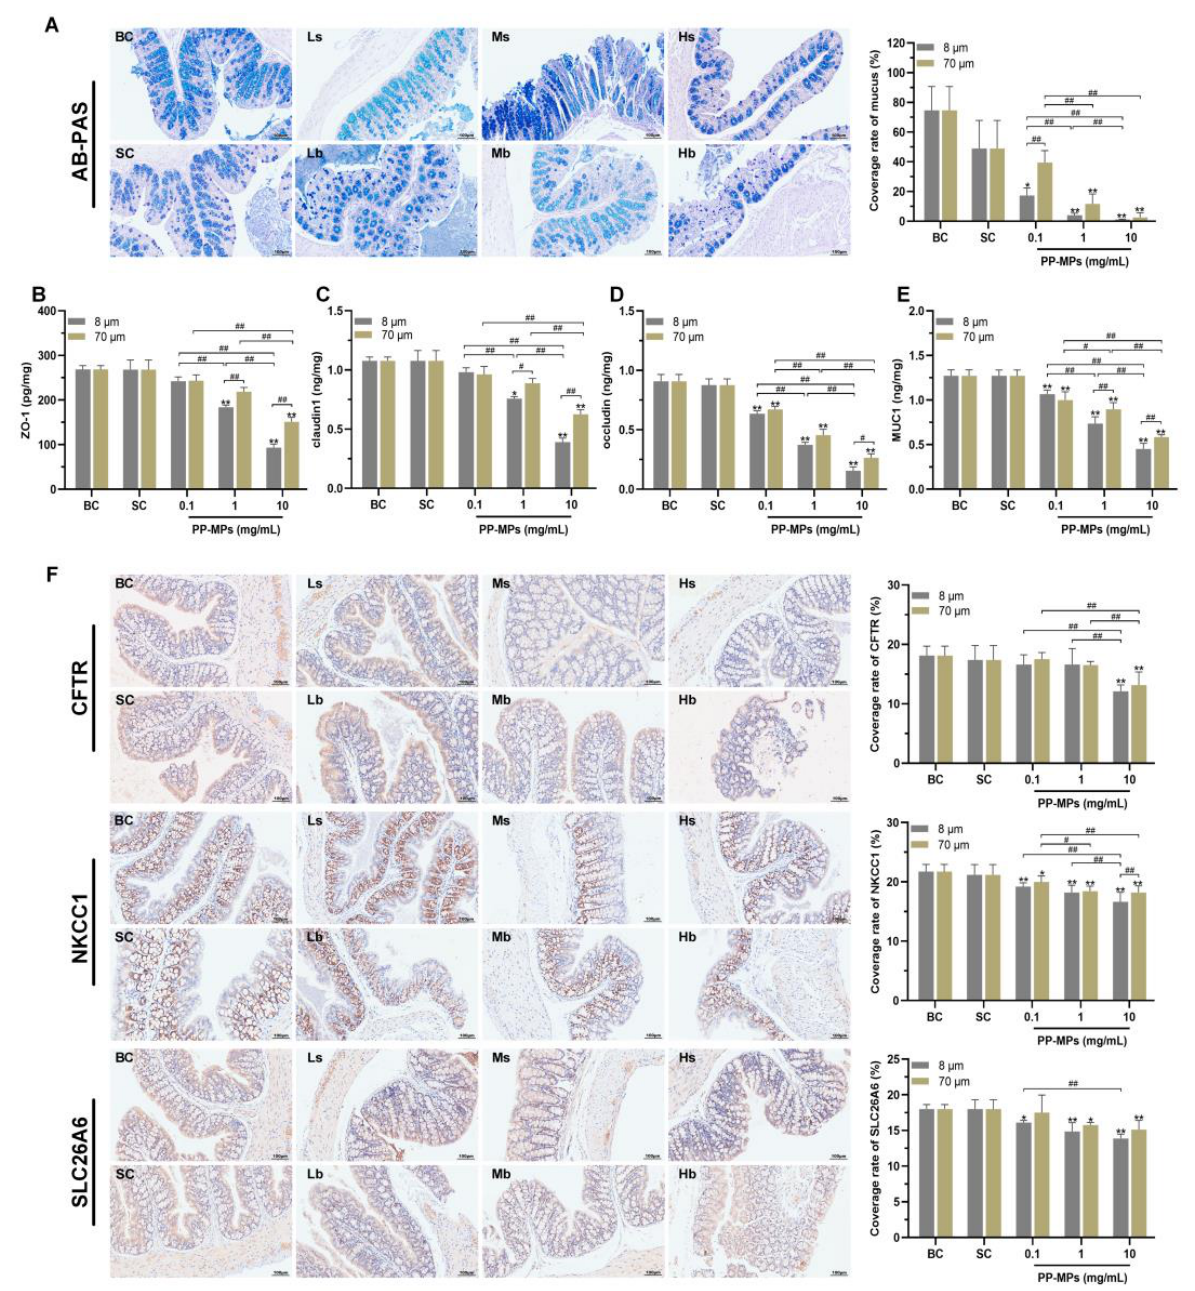
Figure 5. Polypropylene microplastics affect the intestinal barrier in mice. ( A ) AB-PAS staining and the ratio of the mucus coverage area to the entire colon area. Glycogen and neutral mucopolysaccharides in tissues are red, neutral mucus and acidic mucus are purple, and the nucleus is blue. ( B – E ) The expression of ZO-1 ( B ), claudin-1 ( C ), occludin ( D ), and MUC1 ( E ) in the colon. ( F ) Immunohistochemistry of the colonic ion channel transport protein CFTR, NKCC1, and SLC26A6. The nucleus stained with hematoxylin is blue and the positive expression is brown. The values are the means ± SD (normalized amounts of AB-PAS and immunohistochemistry, n = 3; intestinal-barrier-related protein level, n = 5). # p < 0.05, ## p < 0.01 between PP-MP treated groups, and *p < 0.05, **p < 0.01 vs. SC as determined by one-way analysis of variance (ANOVA). BC: blank control (pure water); SC: solvent control (pure water containing 0.01% v / v Tween-80); PP-MPs: